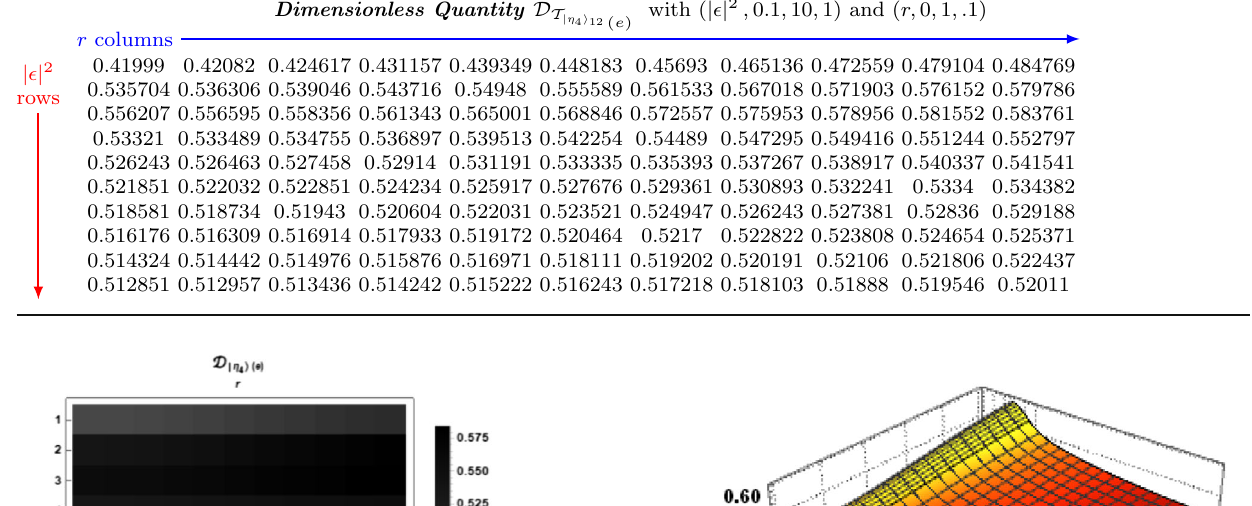
12 showing numerical values of D T tabulated in the form of a | η 4 (cid:2) 12 ( e ) matrix for same range of coherent and squeezing parameters.